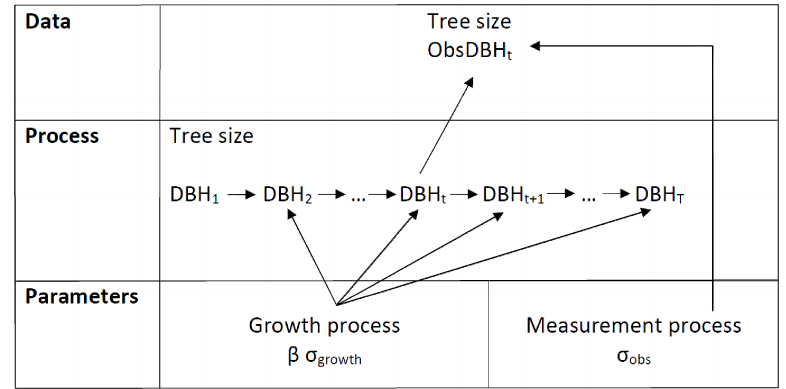
Figure 2. Model structure. Parameters of the growth process are used to model annual growth every year. When the tree is measured an additional measurement process is used to estimate the observed